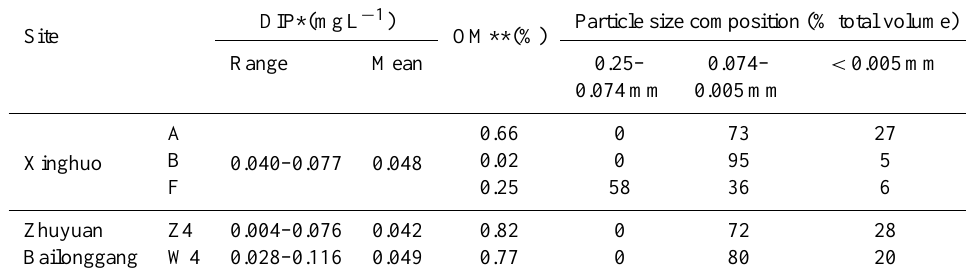
Table 1. Description of different sediment and water samples.